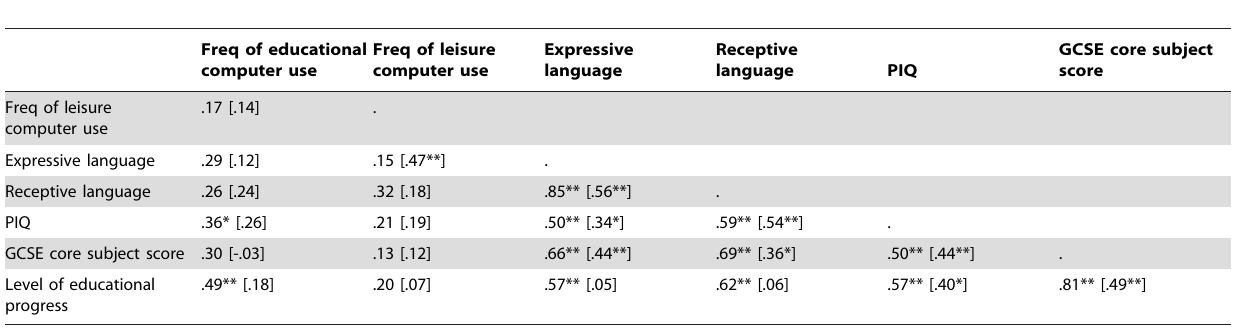
Table 3. Correlations between frequency of computer use and key variables for young people with SLI and TD peers continuing in post-compulsory education.